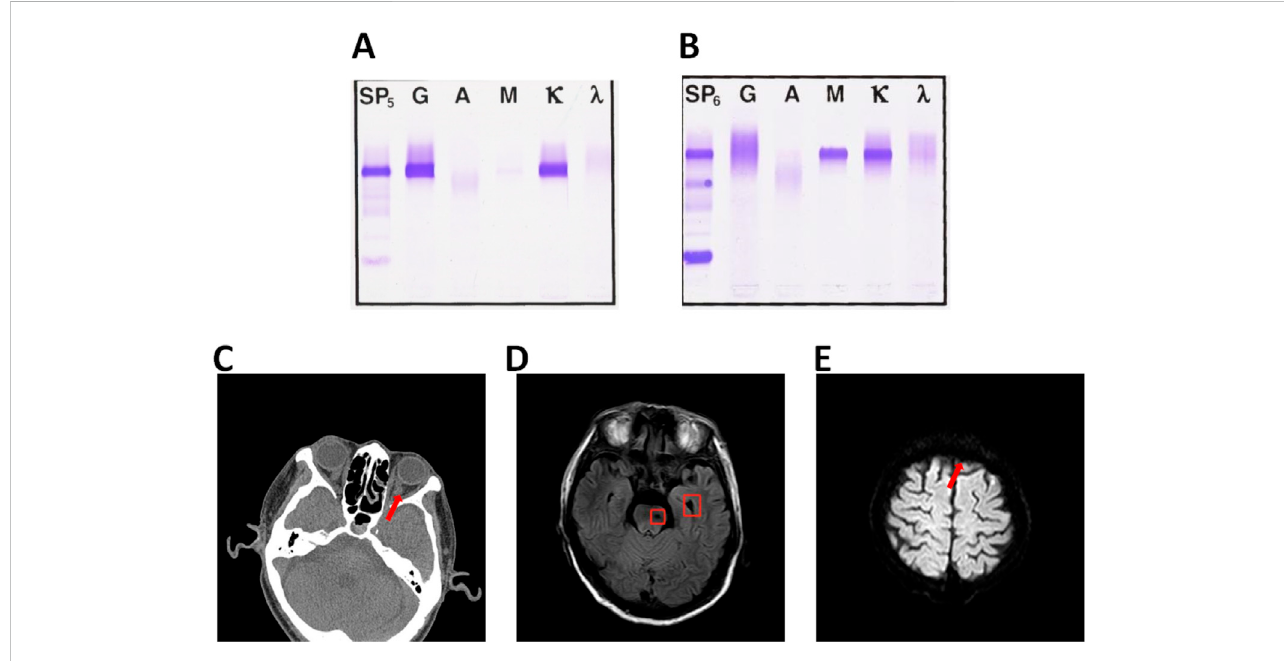
FIGURE 1 (A) Immuno fi xation electrophoresis(serum) abnormal monoclonal bands found in lgG and κ lane. (B) Immuno fi xation electrophoresis (serum) lgM and κ lane. (C) Abnormal signal foci in left pontine and left cerebellar Angle. (D) Left frontal hemorrhage foci. (E) Left frontal infarction foci of